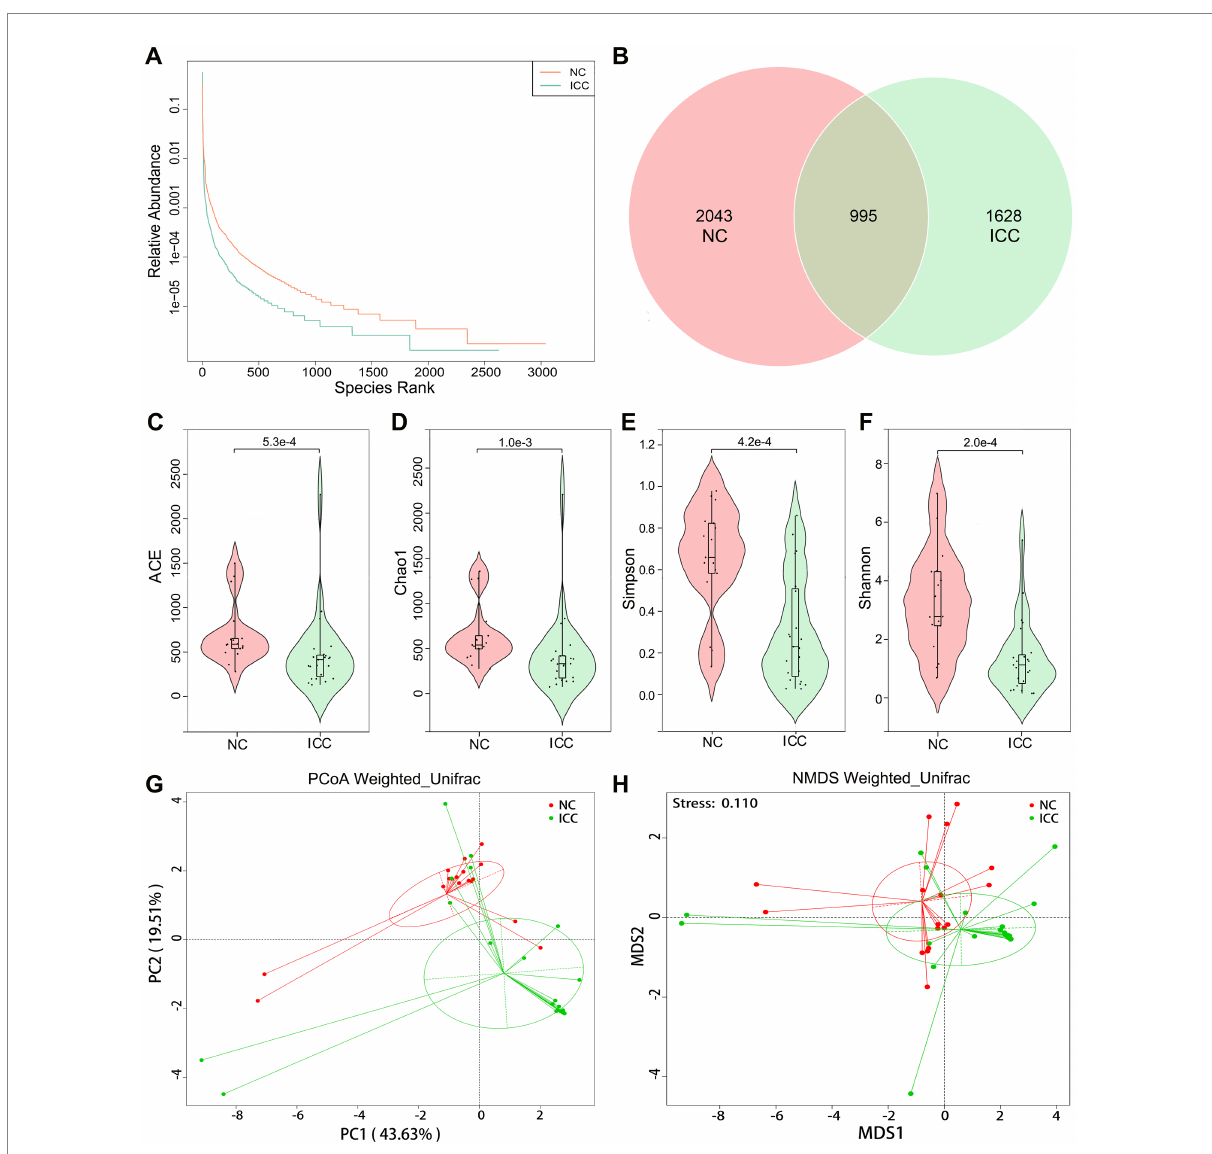
FIGURE 1 Diversity analysis in the ICC and NC groups. (A) Rank abundance curves. (B) Venn diagram displaying the overlap of OTUs identified between the two groups. Alpha diversity was estimated by the ACE index (C) , Chao1 index (D) , Simpson index (E) , and Shannon index (F) . The distributional difference of gut mycobiota profiles was assessed using PCoA (G) and NMDS (H) based on a weighted_unifrac matrix. ICC, intrahepatic cholangiocarcinoma; NC, healthy